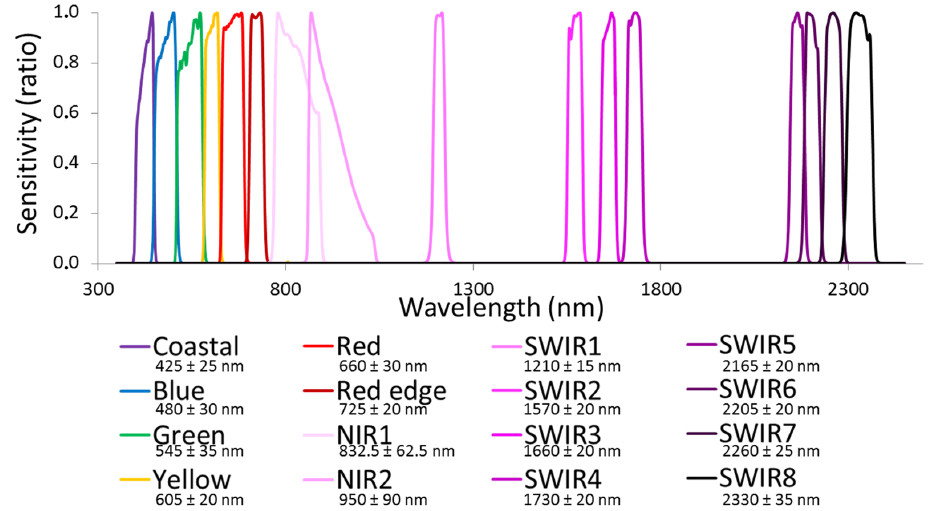
Figure 2. Lineplot of the superspectral (16 bands) WorldView-3 sensor’s sensitivity as a function of their wavelengths.